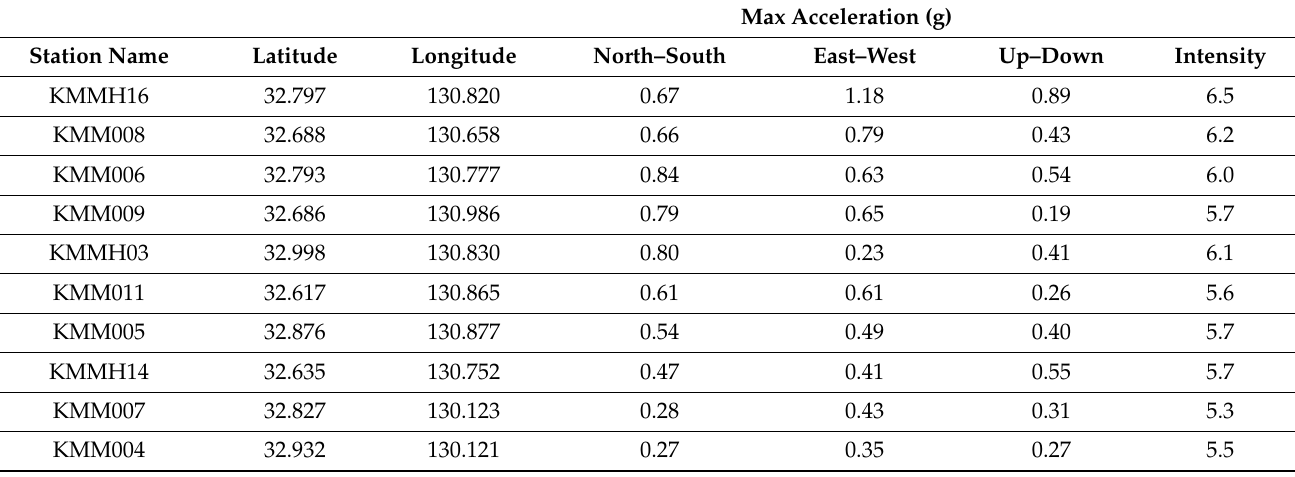
Table 1. Ground motion recording stations, maximum recorded accelerations (g), and intensities from the 16 April 2016 KES mainshock.